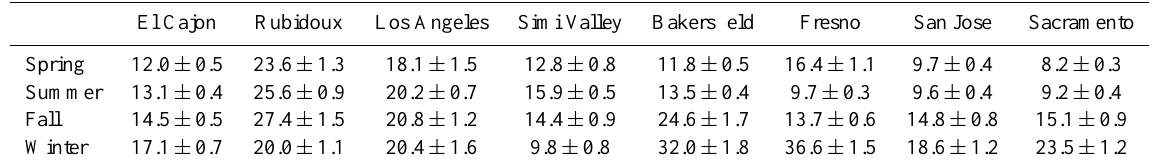
Table 1. Seasonal average mass concentration ( ± standard error) (µgm − 3 ) of ambient PM 2 . 5 at the eight sampling sites in the period between 2002 and 2007.